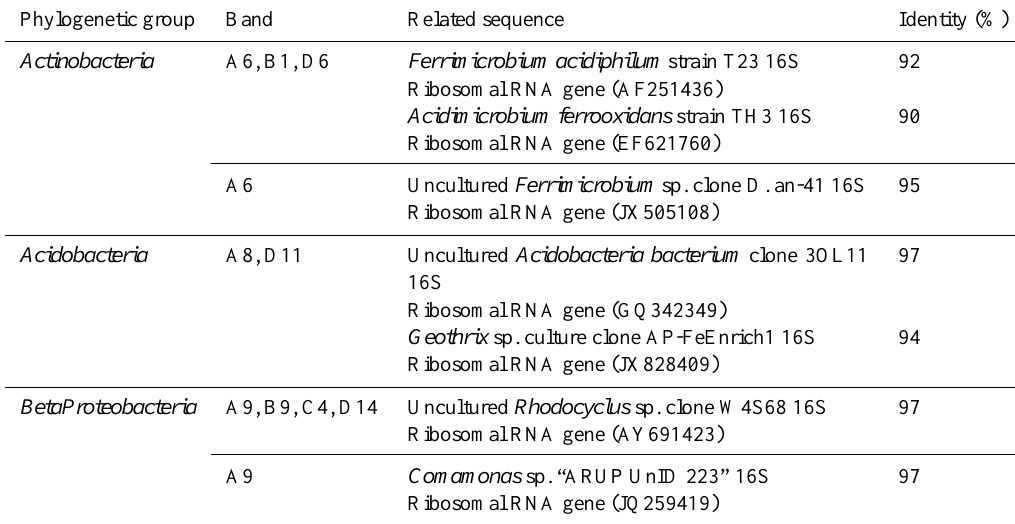
Table 1. Sequence analysis of bands excised from DGGE gels of soil samples with Feammox activity. Phylogenetic